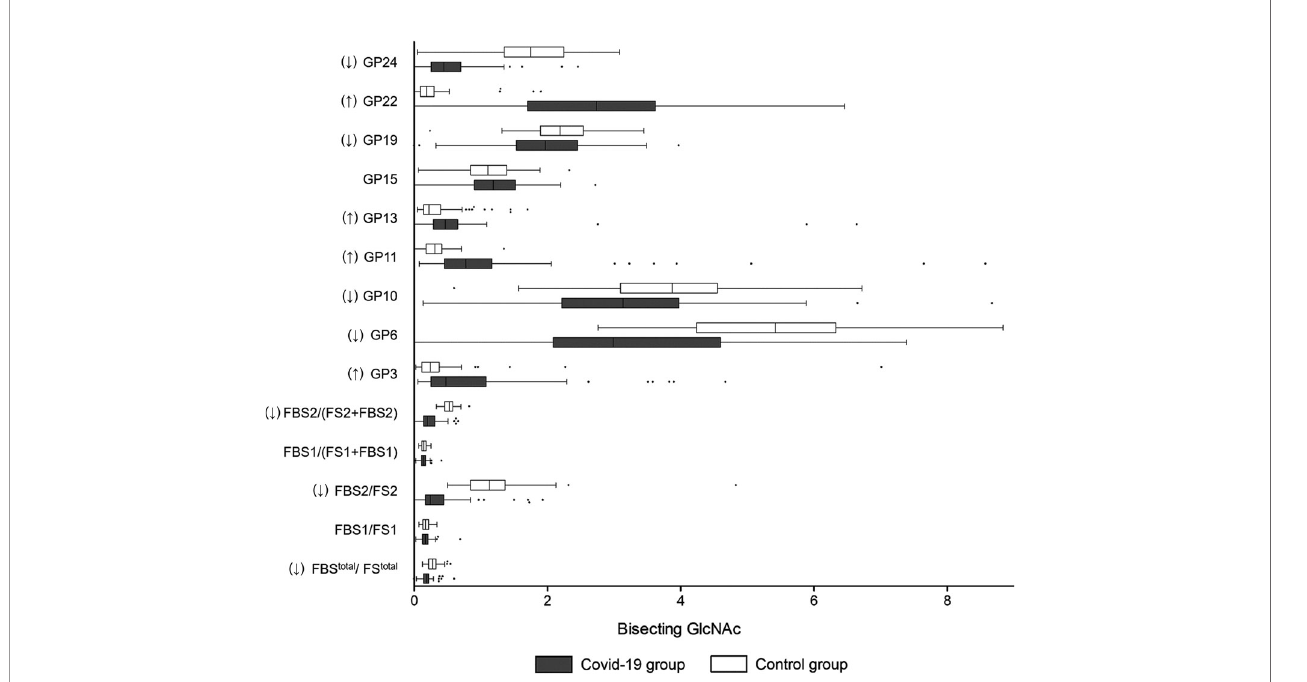
FIGURE 3 | Bisecting GlcNAc on IgG in COVID-19 patients and the healthy controls. B, bisecting N-acetylglucosamine (GlcNAc); F, fucose; G, galactose; GP, glycan peak; S, Sialic acid; ↑ , the glycan in COVID-19 group is signi fi cantly higher than that in the controls; ↓ , the glycan in COVID-19 group is signi fi cantly lower than that in the